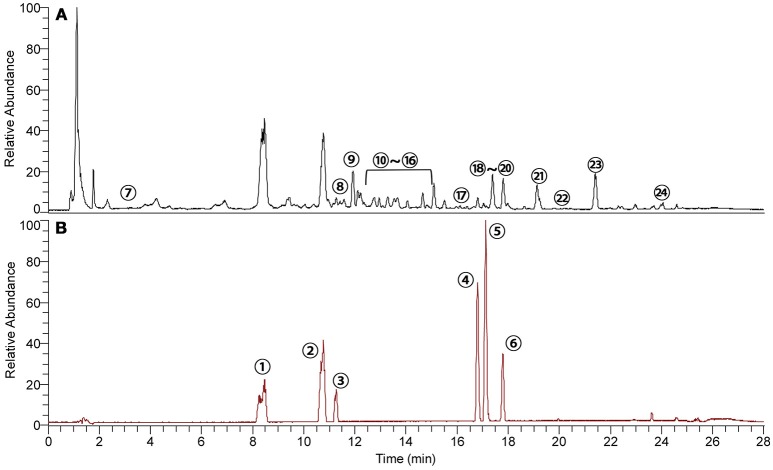
Typical base peak intensity chromatograms of (A) ZT extract and (B) a six-standard mixture analyzed by UHPLC-Q Exactive-Orbitrap-MS. The components are listed in Table 1.